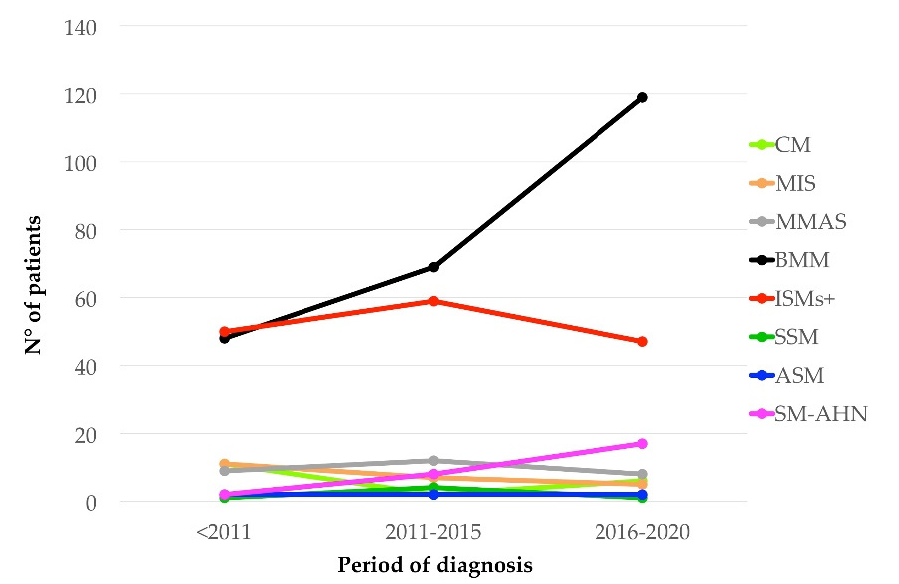
Figure 2. Number of new diagnoses of clonal mast cell disorders according to disease subtype and period of activity. Legend: CM: cutaneous mastocytosis; MIS: mastocytosis in the skin; MMAS: monoclonal MC activation syndromes; BMM: bone marrow mastocytosis; ISMs+, indolent systemic mastocytosis with skin lesions; SSM: smoldering systemic mastocytosis; ASM, aggressive systemic mastocytosis; SM-AHN, systemic mastocytosis with associated hematological neoplasm. Familial mastocytosis was reported in 16 patients (3.0%). Fifty patients (10%) re- ported family history of other hematological disorders, namely, leukemias ( n = 18), lymphomas ( n = 13), multiple myeloma ( n = 5), unspecified anemias ( n = 5), and myelo- dysplastic syndromes ( n = 4).